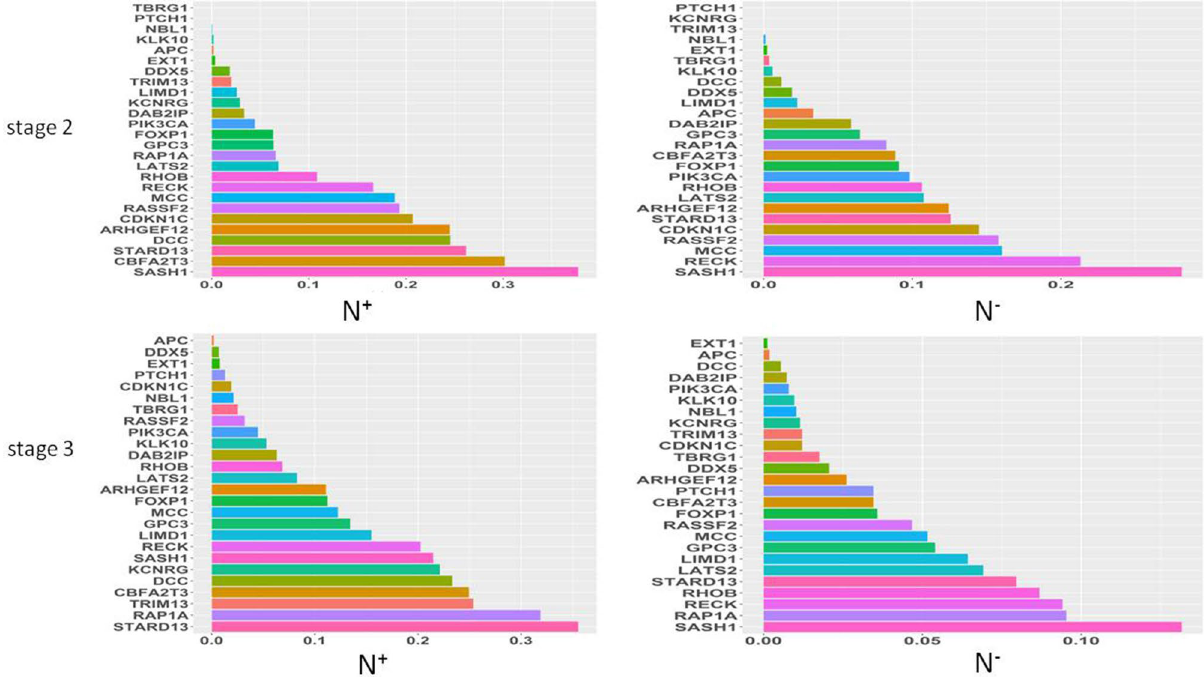
Figure 6. Histogram plots for N + and N − of TS genes. Network score or N-score is defined as ratio of node number shared with a TS gene and all the other TS genes in a network constructed at a given significance level to that in a network constructed at insignificance level(r > 0 or r < 0). N -score is given by N + and N − (see “Methods” for detail definition and calculation). N + is used to measure accordant effects of a TS gene in